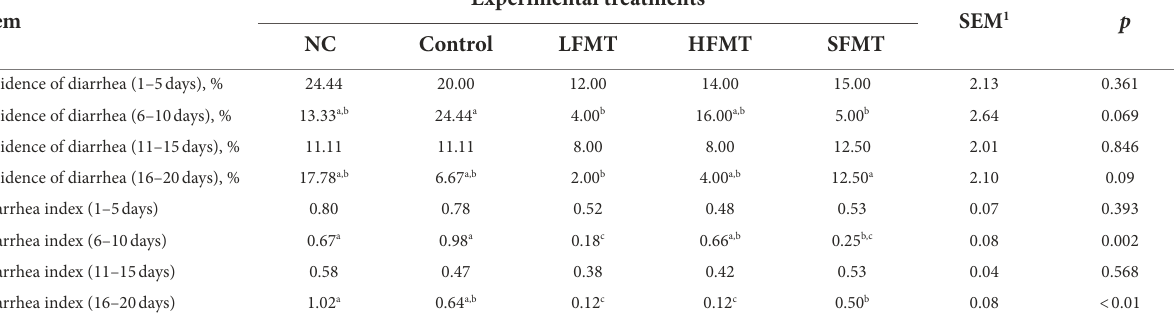
TABLE 1 Effects of different FMT treatments on diarrhea incidence and diarrhea index of weaned calves at different time points after weaning.